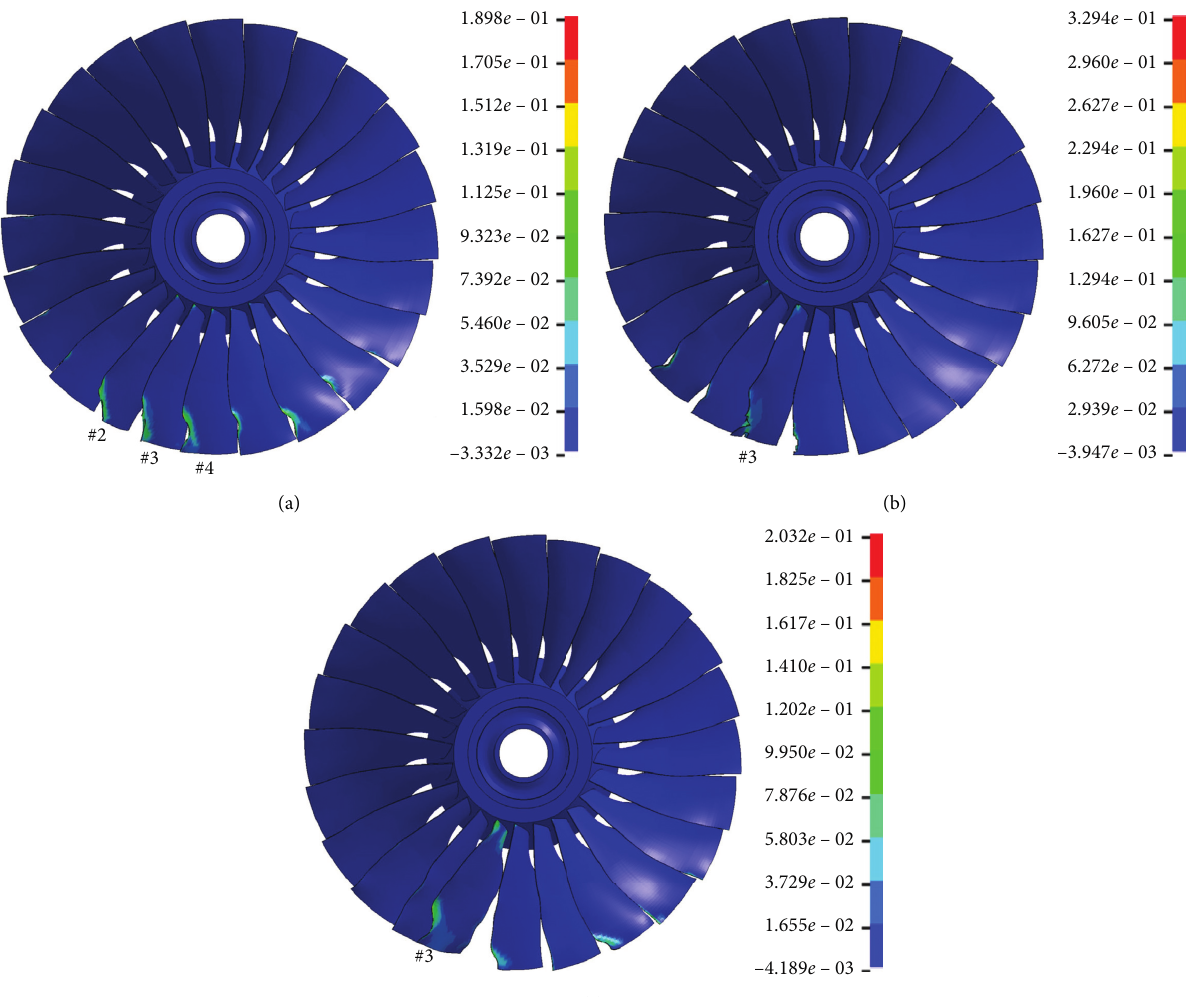
Figure 16: Effective plastic strain contours at time t � 10ms. (a) 0 ° . (b) α � − 45 ° . (c) β � − 60 °